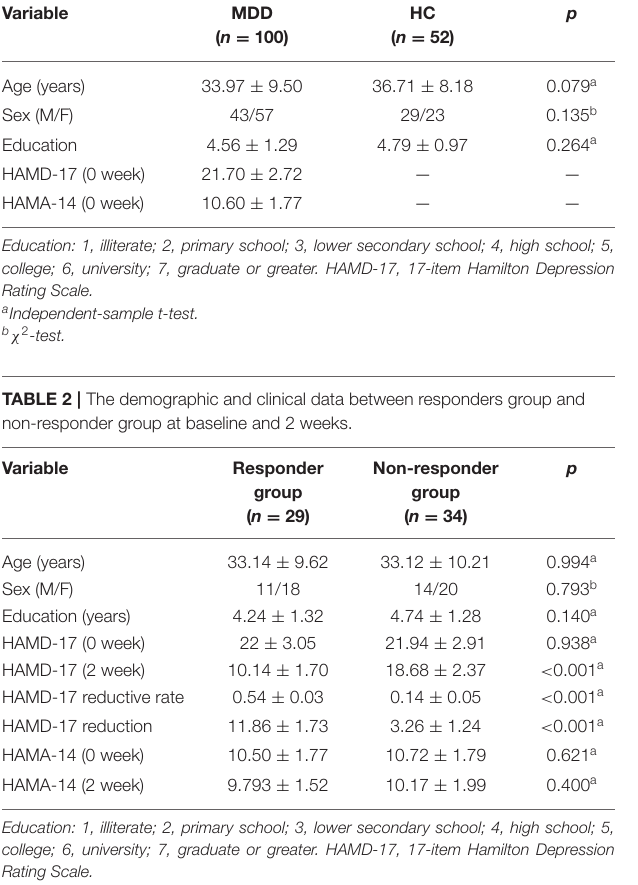
TABLE 1 | The demographic and clinical data between the MDD group and the HC group at baseline. Variable